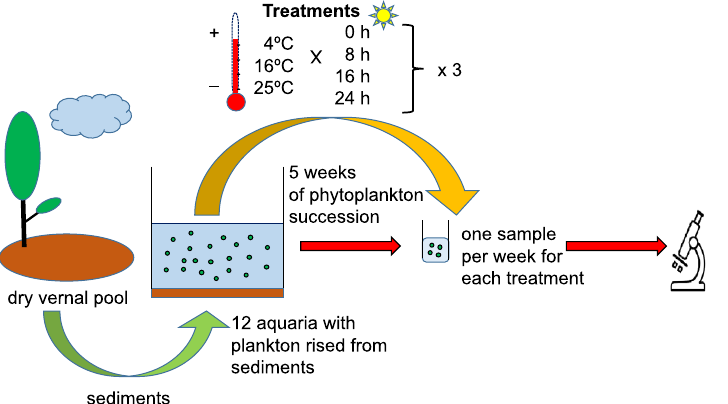
Figure 8. Successive stages (steps) of investigations: from the field through the experimental design/laboratory experiments in microcosms. The graph was created using MS PowerPoint